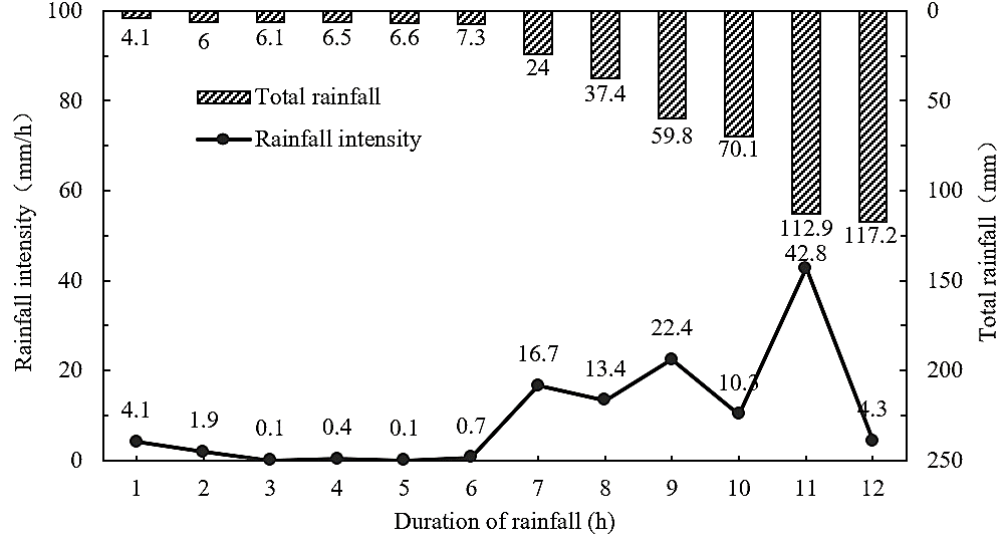
Figure 5. Historical rainfall data in Nanjing on 7 August 2017.